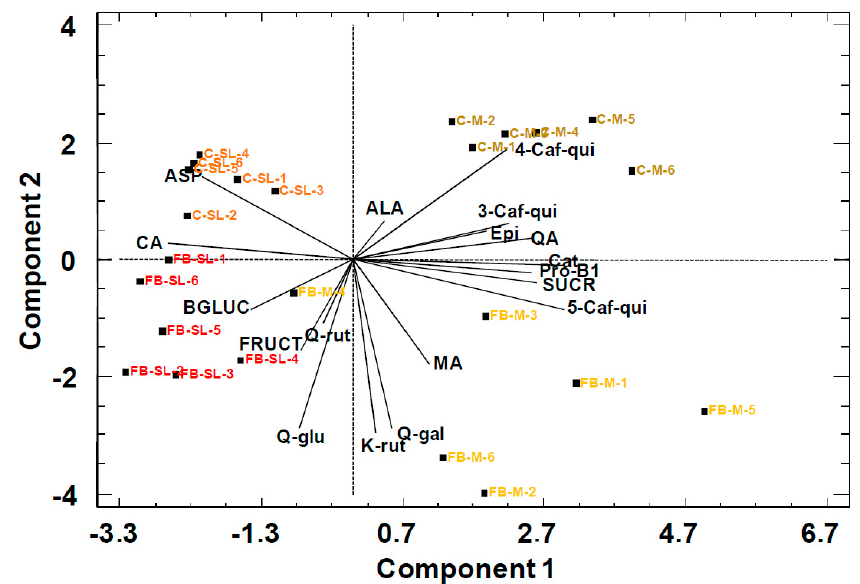
Figure 5. PCA bi-plot of peach purees with primary metabolites and phenolic compounds as statistical variables. FB: Freshly blended, C: Commercial, SL: Spring Lady cultivar, and M: Miraflores cultivar. Ending number is the batch number. PC1: 37%, PC2: 22%.